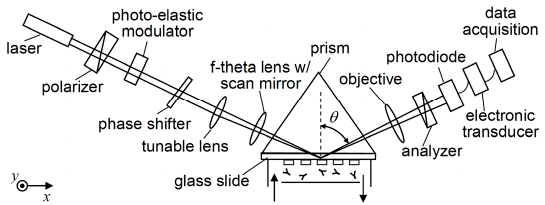
Figure 1. Schematic diagram showing total internal reflection oblique-incidence reflectivity difference (TIR OI-RD) for the label-free detection of a microarray. A prism enables the illumination beam to undergo total internal reflection and focus on the backside of the glass slide. With a combination of beam scanning along the y-axis and sample movement along the x-axis, the TIR OI-RD microscope is able to investigate tens of thousands of biomolecular reactions in a single experiment. An electronically tunable lens is used for focal point correction to obtain a good quality, large microarray image.